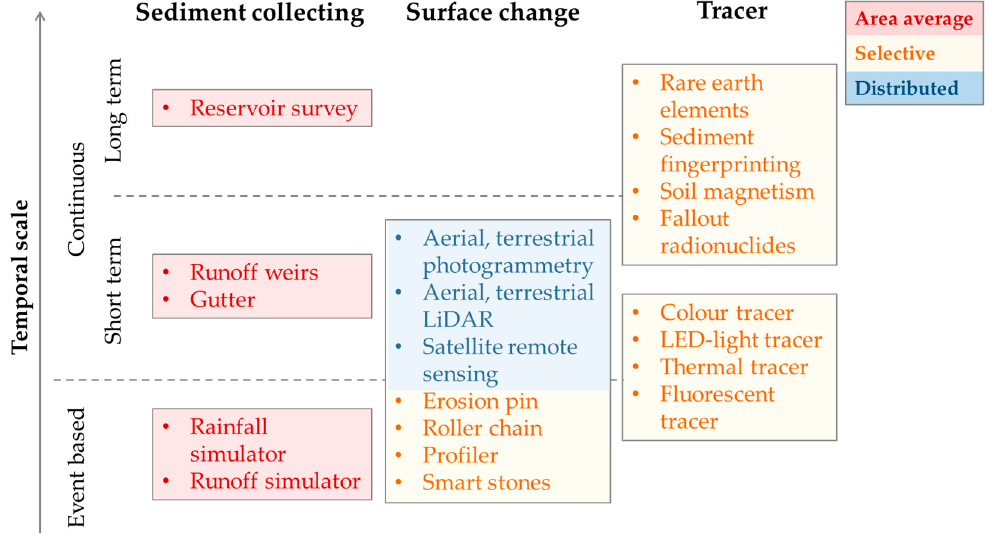
Figure 3. Overview of soil and soil erosion assessment techniques, structured by their type of assessment, their output (area average, selective or distributed) and their temporal scale. The methods presented in this figure are not weighted and do not claim to be exhaustive. The selection is based on Guan et al. [75], Li et al. [71], Jester and Klik [76], Thomsen et al. [77], Batista et al. [78] and Rodrigo ‐ Comino [74].